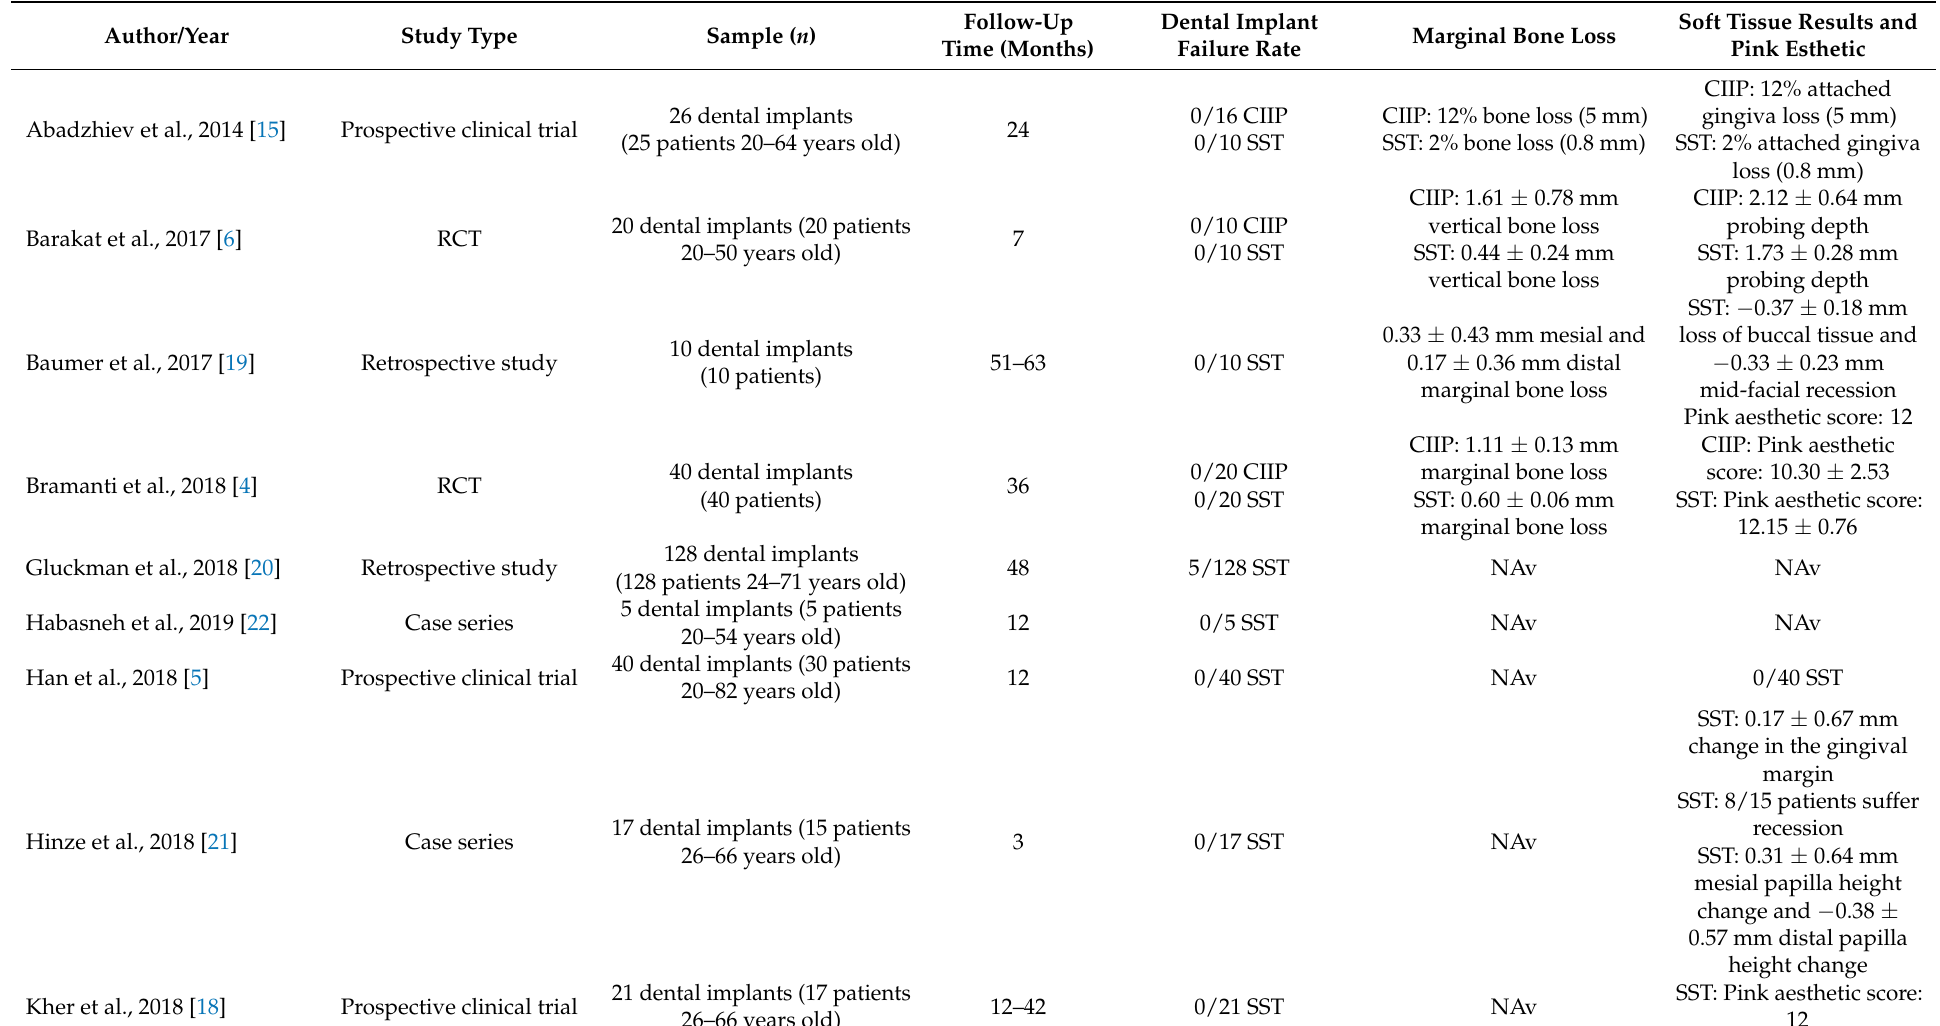
Table 2. Qualitative analysis of articles included in the systematic